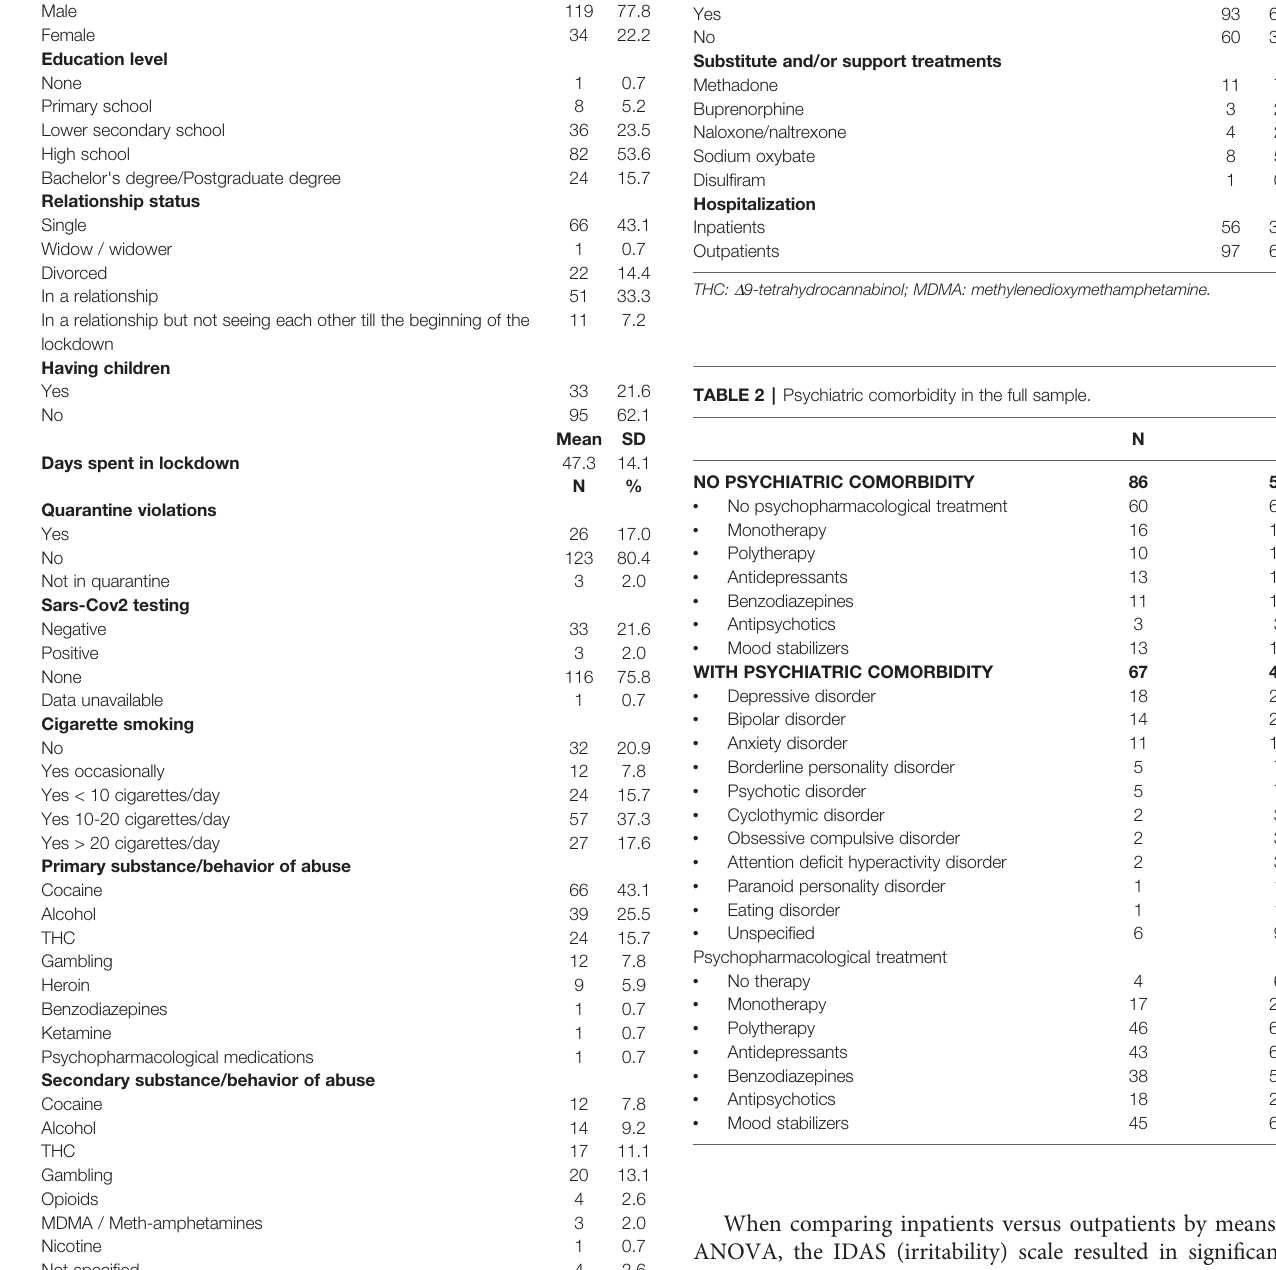
ANOVA, the IDAS (irritability) scale resulted in signi fi cantly higher levels among inpatients. Comparing dual diagnosis participants against non-dual diagnosis participants, BDI-II, DTS, and somatization scores were signi fi cantly higher among dual-diagnosis patients. VAS quality of life scored higher in the non-dual diagnosis group. Results of ANOVA tests are detailed in Table 7 .